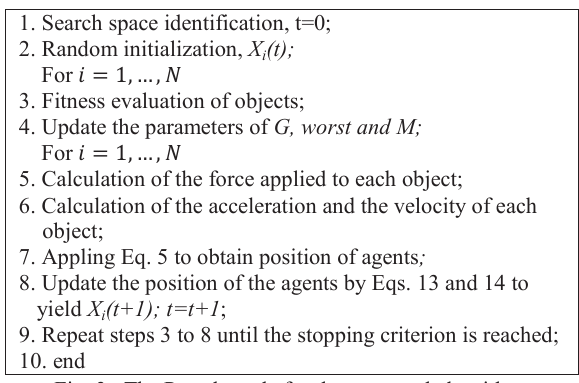
Fig. 3. The Pseudo code for the proposed